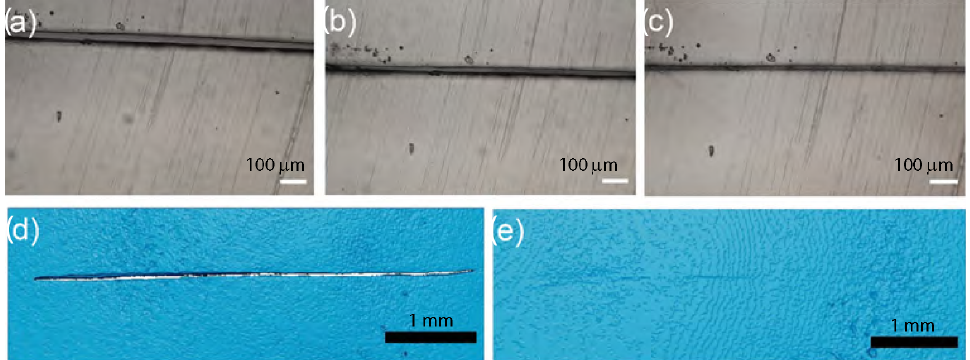
Figure 16. Self-healing behavior of ionic PDMS—nanosilica composites, ( a ) before and after thermal treatment (80 °C) in a humid environment for ( b ) 30 min and ( c ) 1 h. Micro-computed X-ray tomography (micro-CT) results of the same specimen confirm this behavior, showing the entire scratch ( d ) before healing and ( e ) after healing for 1 h at 80 °C in a humid environment. Reprinted with permission from Mugemana et al.